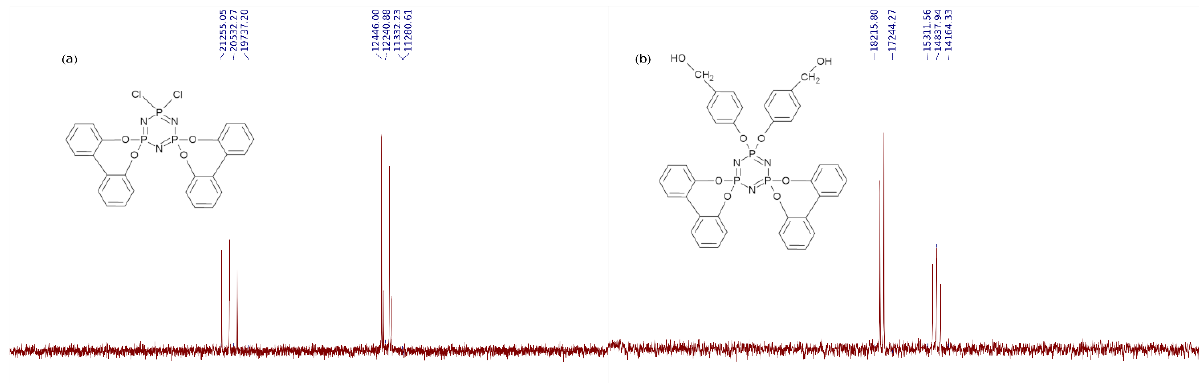
Figure 5. 31 P NMR spectra in CD 3 COCD 3 of ( a ) = 2,2–dichloro–4,4,6,6,-bis[spiro(2 ′ ,2 ″ –dioxi–1 ′ ,1 ″ – biphenyl)]cyclotriphospazene and ( b ) = 2,2–bis(4–formylphenosy)–4,4,6,6,–bis[spiro(2 ′ ,2 ″ –dioxi– 1 ′ ,1 ″ –biphenyl)]cyclotriphospazene.